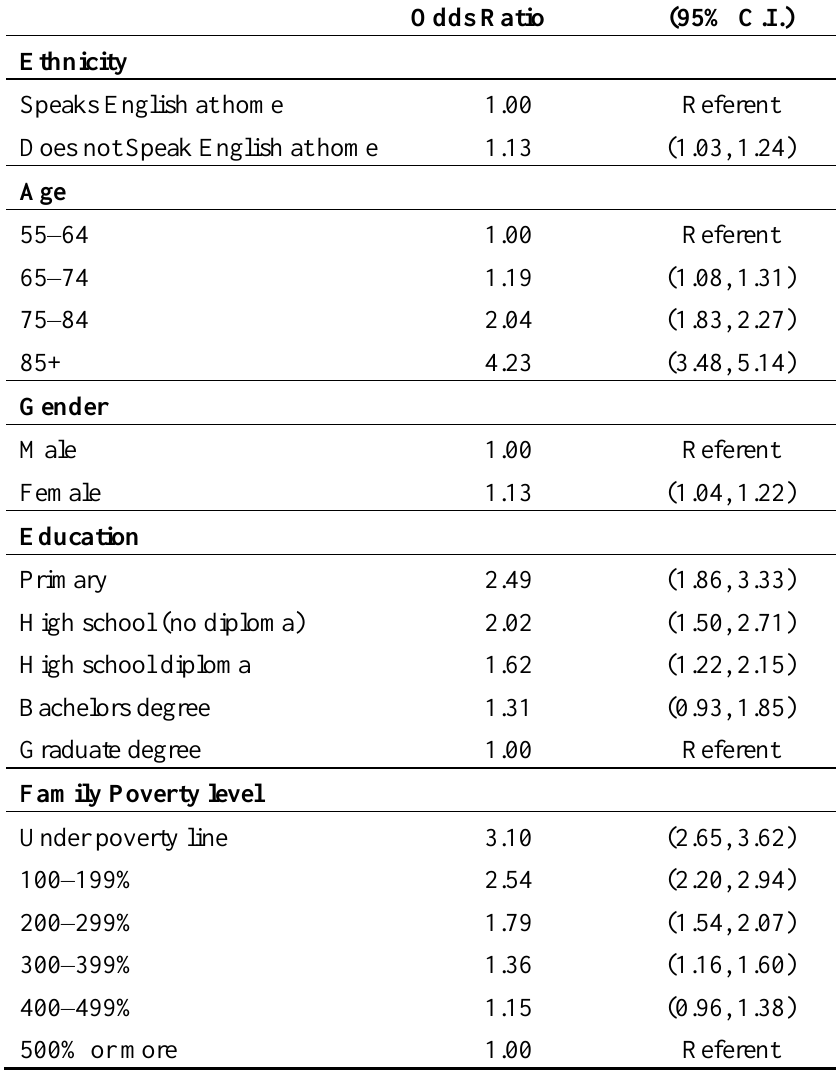
Table 5. Logistic regression analyses of functional limitations status by language spoken at home and socio-demographic characteristics among U.S. born Mexican Americans aged 55 and